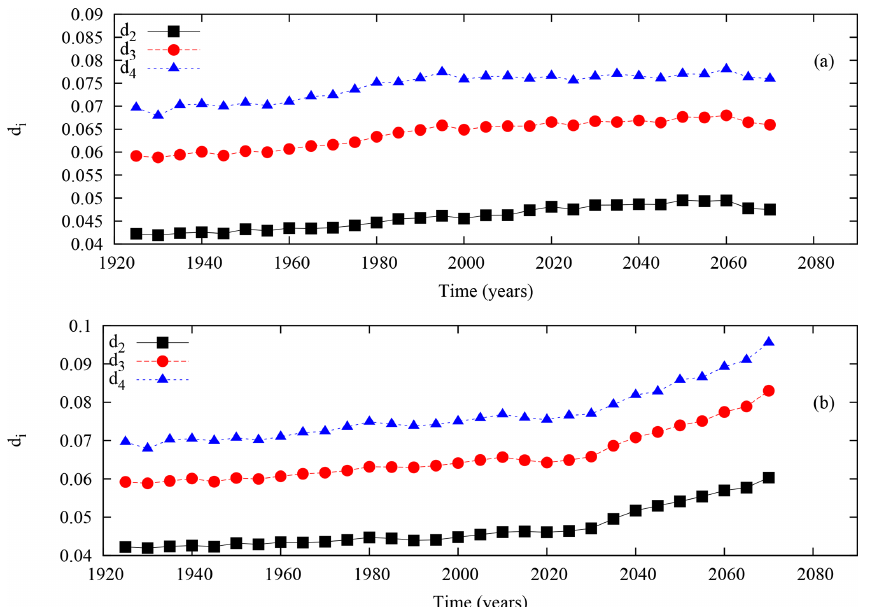
Figure 6. Temporal evolution of the lower bounds of the entropy production d 2 , d 3 and d 4 combining the statistics of the 15 Met Office model versions, under (a) RCP2.6 and (b)